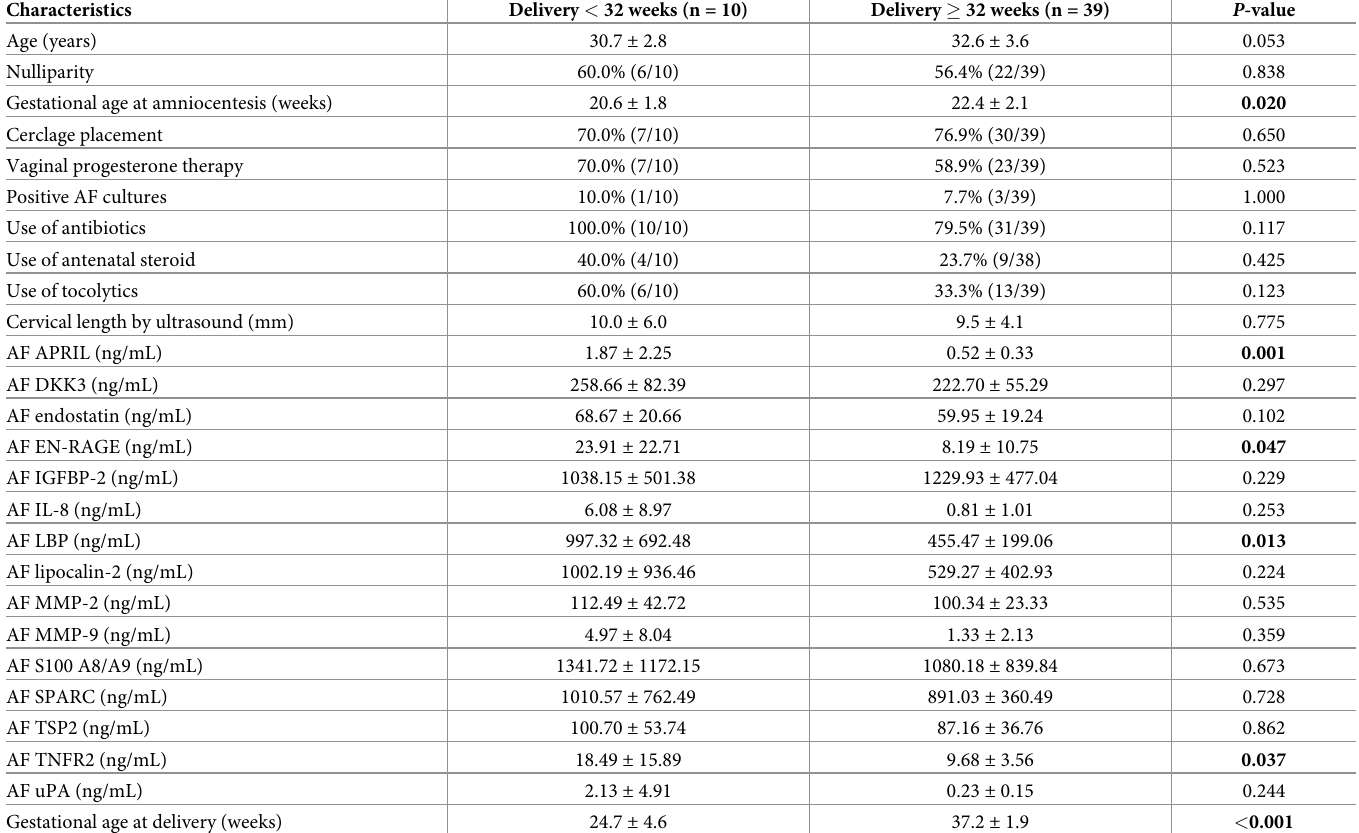
Table 4. Demographic and clinical characteristics, and quantification of the selected candidate biomarkers of interest in women with a short cervix stratified according to the occurrence of spontaneous preterm birth. Characteristics